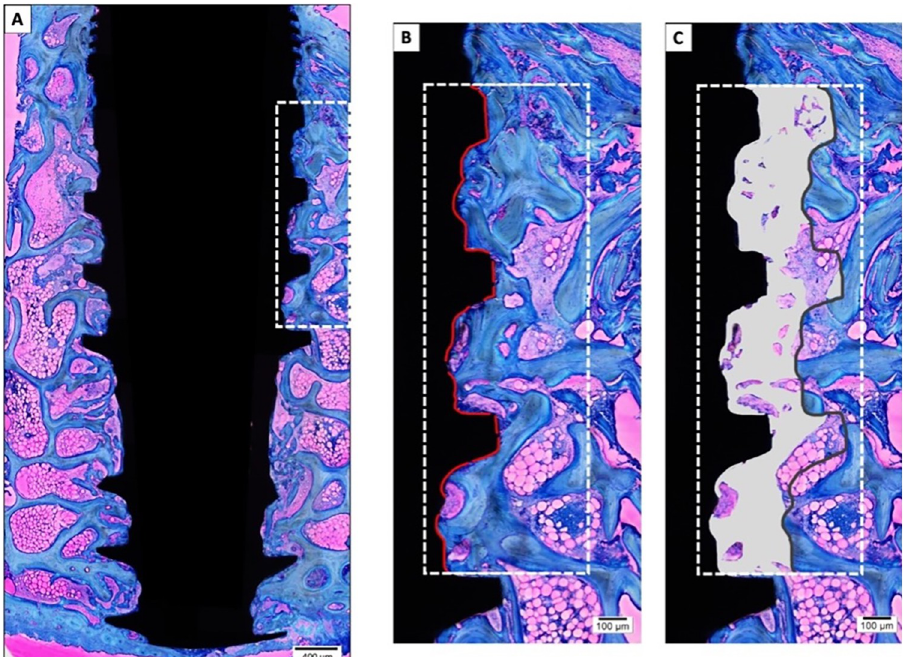
Fig 2. Histomorphometry for BIC and BAFo analysis. (A) Histological reconstruction of the implant and adjacent bone. (B) The line of interest for BIC evaluation is shown within the dotted box. In the long axis of the implant, the profile drawing was traced from the first implant thread to the beginning of the fourth thread. The red line denotes BIC. (C) Delineation of the BAFo area of interest. A line identical to the implant profile diagram was duplicated and aligned at 270 μ m in the horizontal plane (total area). BAFo was manually determined for further analysis (total area/ BAFo; %). Staining with toluidine blue and acid fuchsin was used. Scale bars: 400 μ m, A; 100 μ m, B and C.